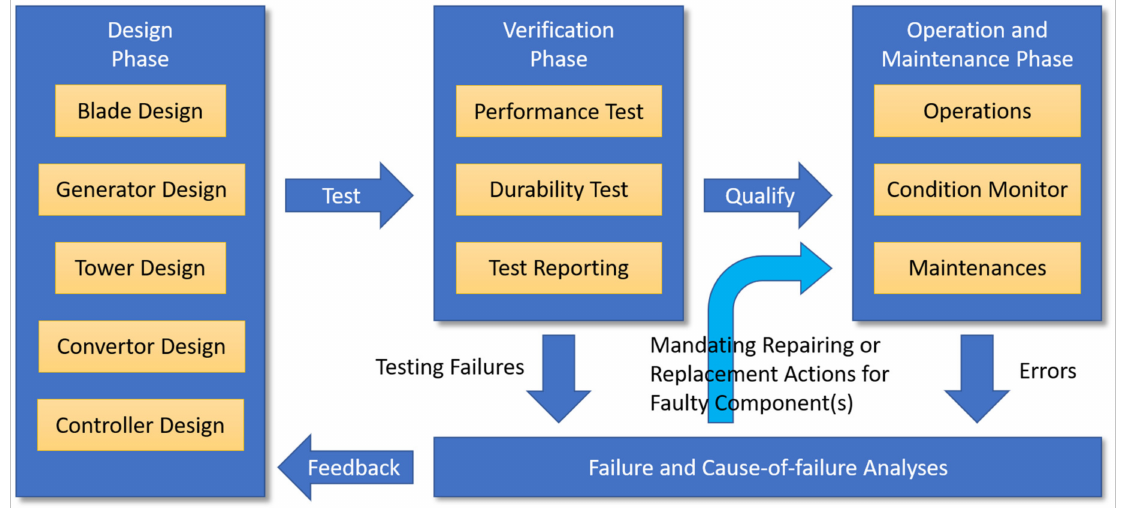
Figure 1. The life cycle of wind turbine